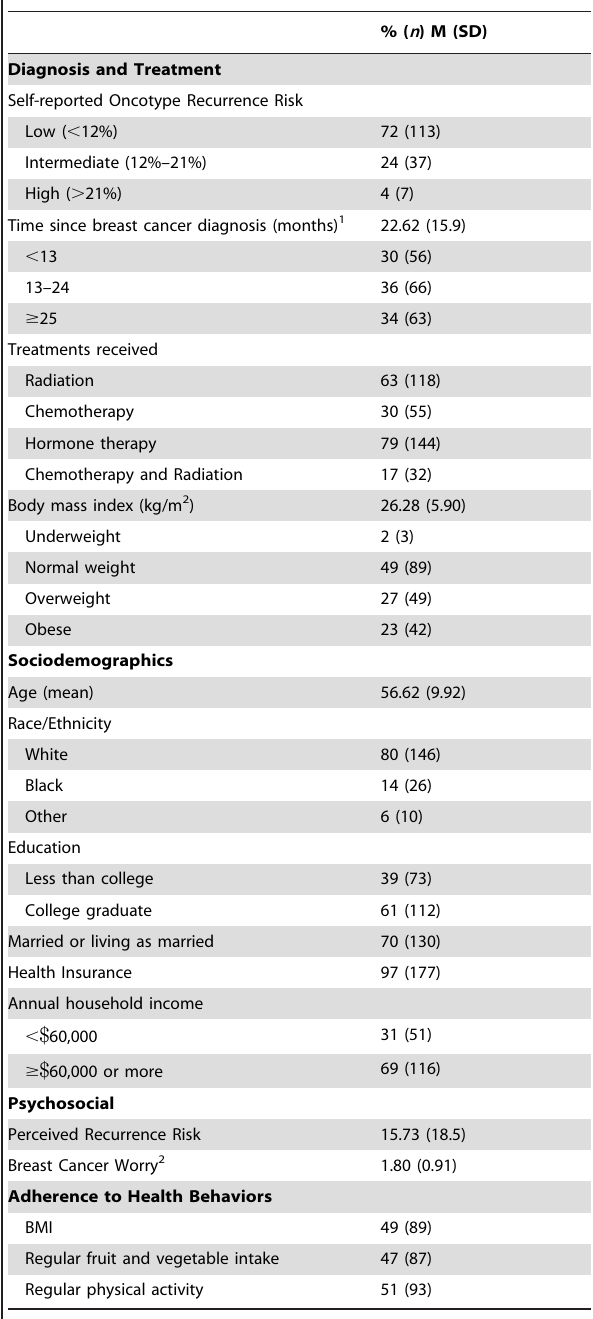
Table 1. Participant Characteristics ( n